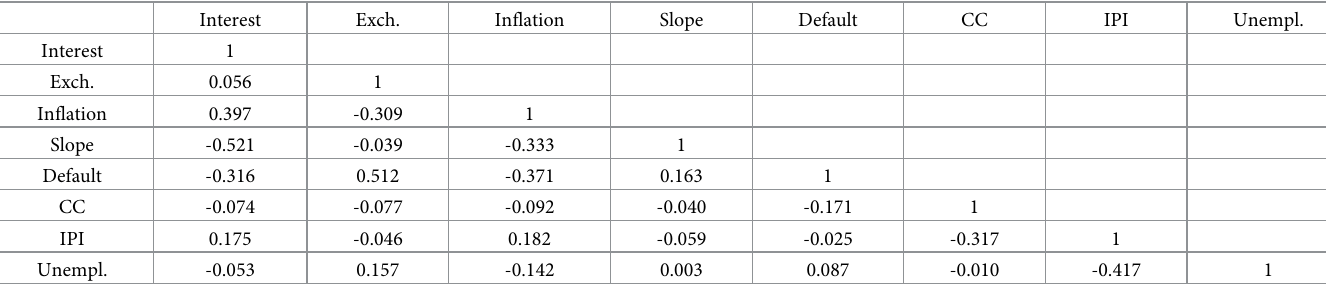
Table 4. Correlation coefficients between macro-economic variables.